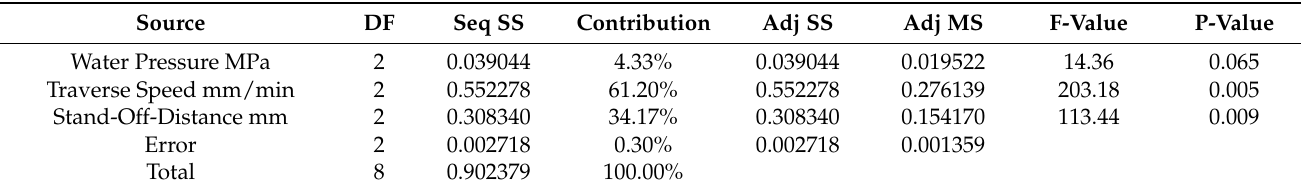
Figure 9. S/N ratio average value of input cutting parameters of the 4 mm thickness of sugar palm fiber reinforced unsaturated polyester (SPF-UPE) composite cut with abrasive water jet technique. Table 21. ANOVA table for kerf taper angle response of input cutting parameters of 4 mm thickness of SPF-UPE composite cut with abrasive water jet